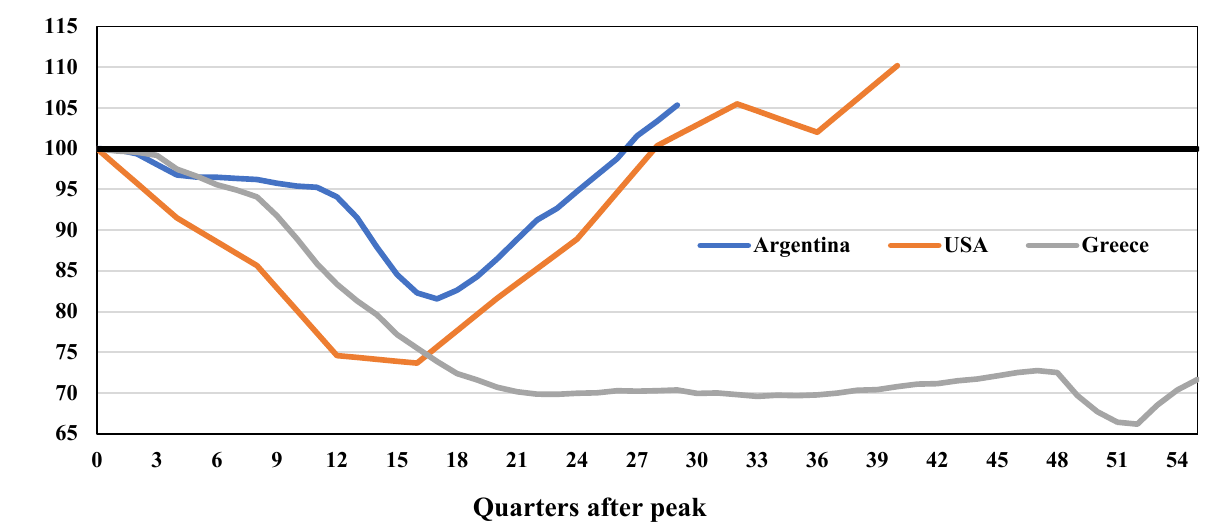
Figure 1. How long recessions last? Changes from peak GDP (100) during recessions documented for Argentina (1998), Greece (2009) and USA (1929). Source: Eurostat, OECD and author’s calculations.